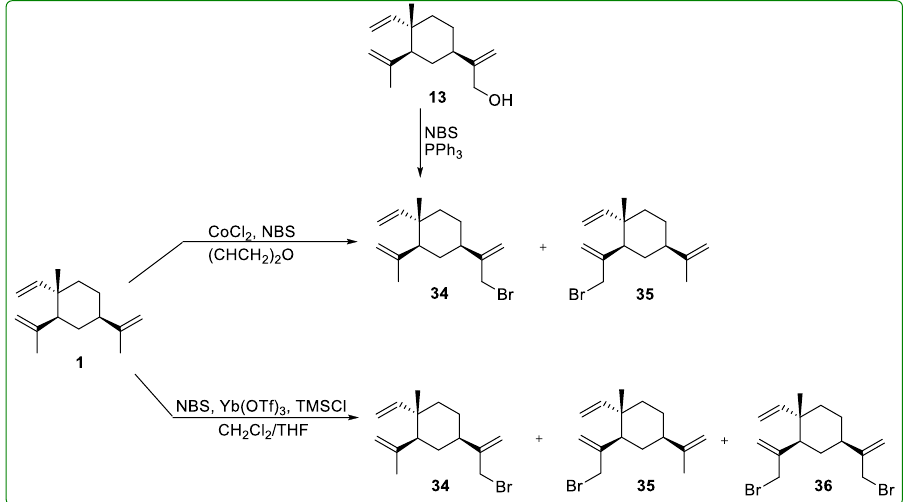
Figure 7. The bromination reaction and the chemical structures of related products 34 – 36 .